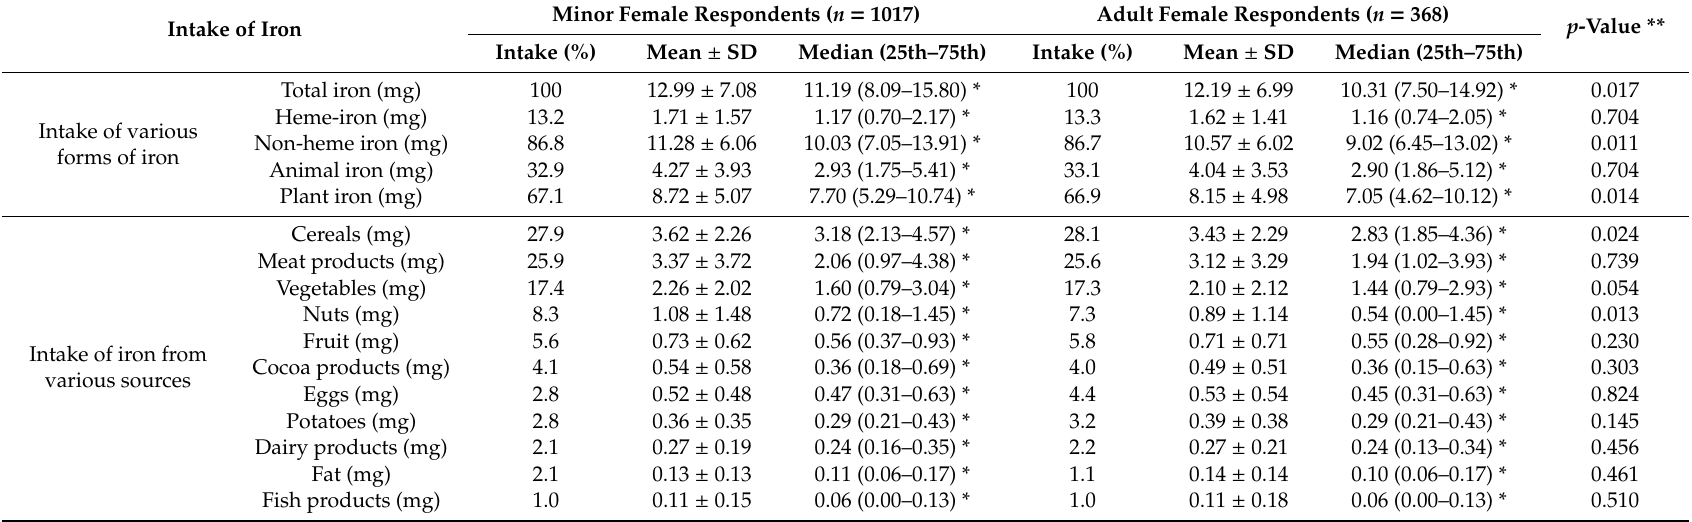
Table 3. Comparison of intake of various forms of iron along with that of iron intake from various sources in the national sample of Polish adolescents, in the sub-groups of minor and adult female